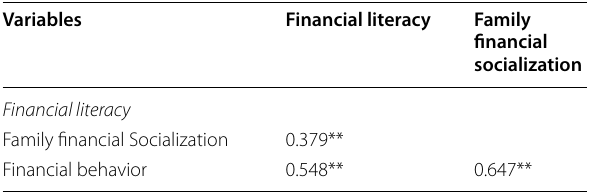
Table 4 Pearson correlation between financial literacy, financial behavior and family financial socialization